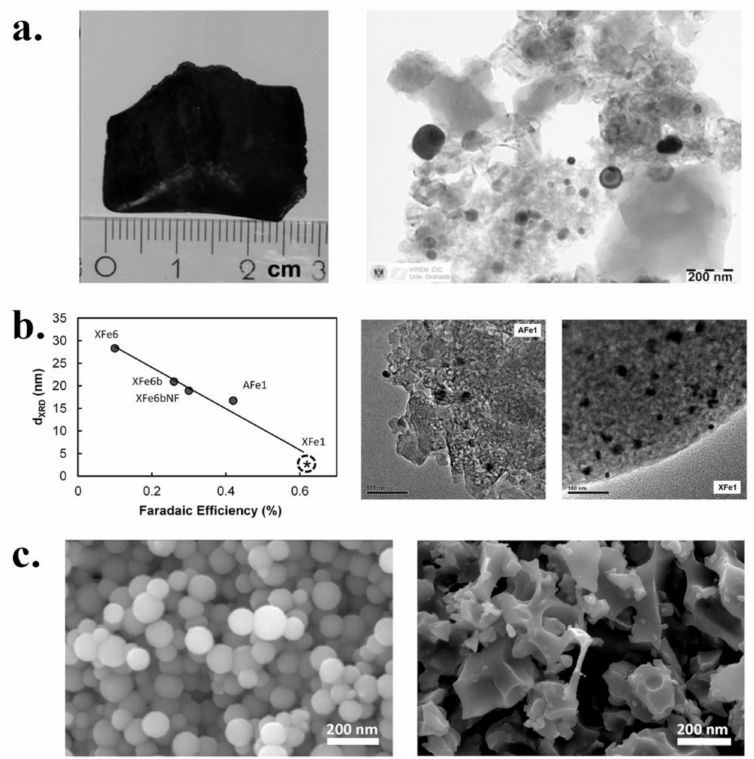
Figure 22. Carbon gels as metal nanoparticle supports in the electrochemical reduction of CO 2. ( a ) Photograph and HRTEM images of carbon xerogel supporting Ni nanoparticles, adapted from [209]. ( b ) Relationship between the size of iron particles by XDR vs. faradic efficiency (Left) and HRTEM images of Fe metal nanoparticles in carbon gels (right), adapted from [211]. ( c ) SEM images of carbon gels prepared using Span 80 and CTAB as surfactants, adapted from